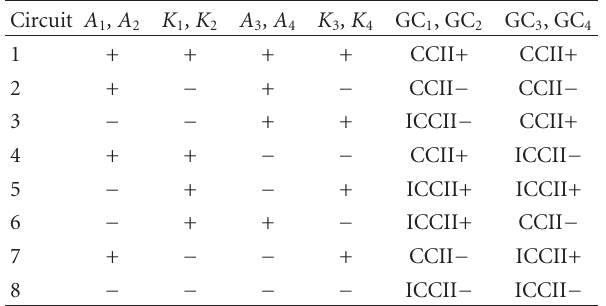
Table 1: Eight alternative conveyor circuits based on Figure 5(a).